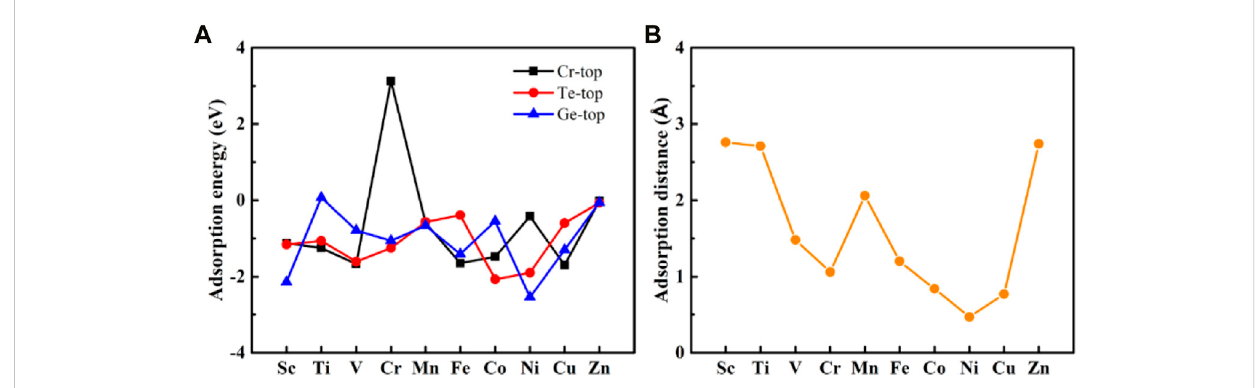
FIGURE 2 (A) The adsorption energy of monolayer Cr 2 Ge 2 Te 6 for transition metals at three distinct adsorption positions: Cr-top, Te-top, and Ge-top. (B) The adsorption distance of transition metals adsorbed by monolayer Cr 2 Ge 2 Te 6